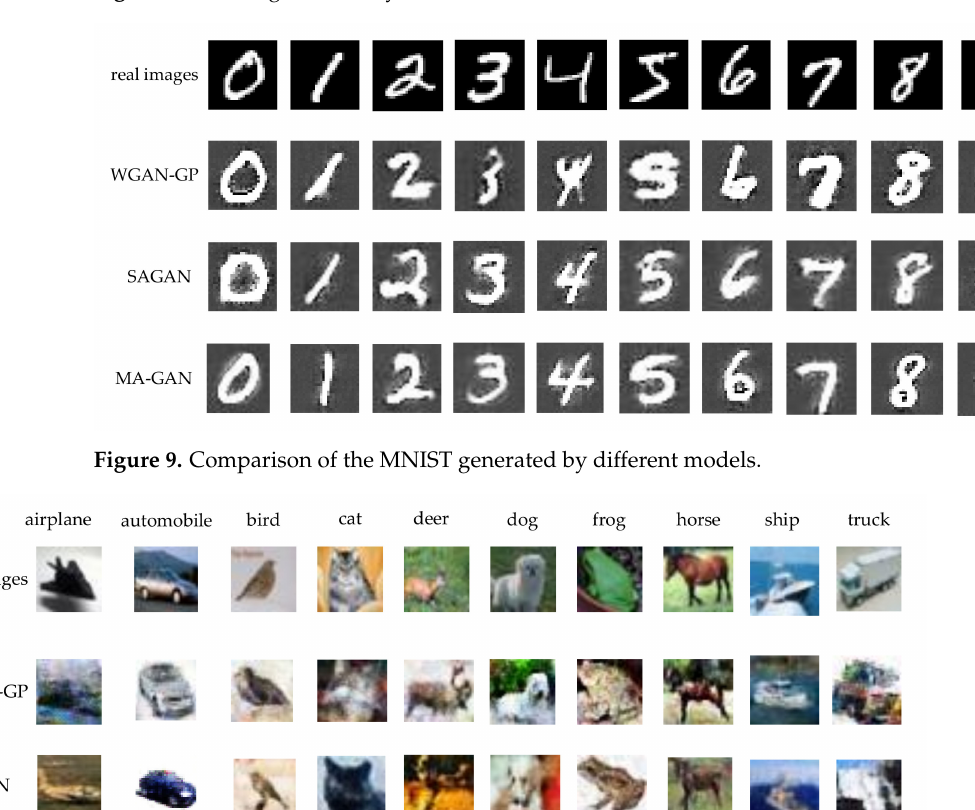
Figure 8. CelebA generated by different models.